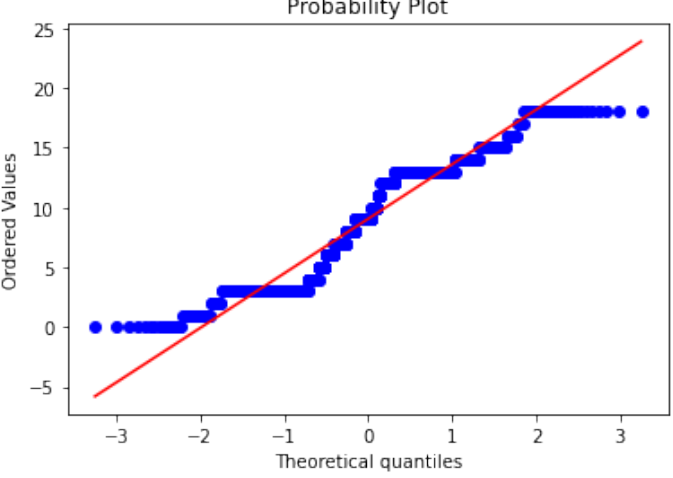
Figure 5. Distribution of an individual data columns of the